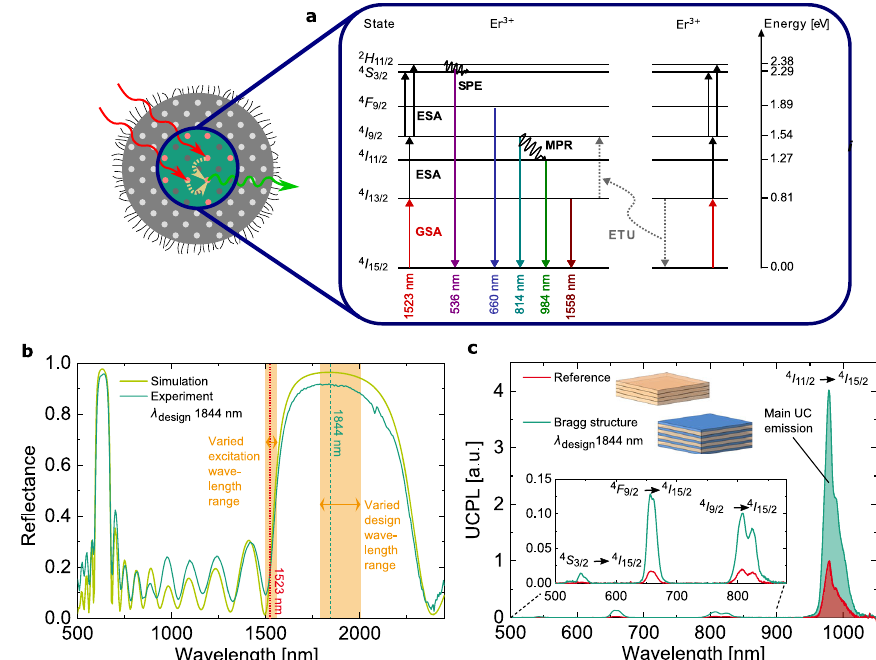
Fig. 2 Design and upconversion photoluminescence (UCPL) of a Bragg structure. a Energy level diagram of the fi rst seven energy levels of β -NaYF 4 :25% Er 3 + , including the processes: ground- and excited-state absorption (GSA, ESA), multi-phonon relaxation (MPR), energy transfer upconversion (ETU) (one exemplary ETU process shown), and spontaneous emission (SPE). b Re fl ectance of a fabricated Bragg structure with the matched simulated re fl ectance at a design wavelength λ design = 1844 nm. The 40 investigated sample designs range from λ design of 1784 nm to 2005 nm. For UCPL measurements, the excitation wavelength is varied from 1500 nm to 1560 nm. c Measured UCPL under 1523 nm excitation at 1.48 W cm − 2 irradiance using an integrating sphere to collect the integrated light from all angles. Due to the photonic effects on UC, in the Bragg structure, all UC emission is signi fi cantly enhanced. The relative enhancement of the main UCPL at 984 nm (UCPL rel ) in the Bragg structure compared to the reference is